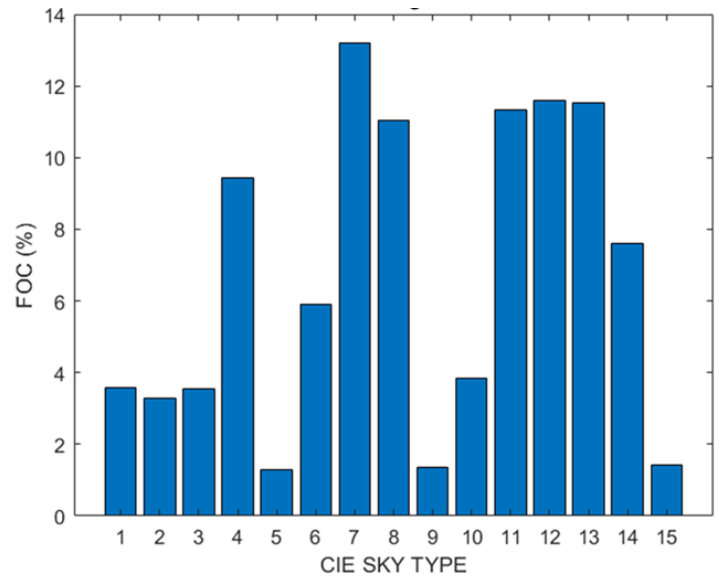
Figure 5. Frequency of occurrence (FOC, %) of CIE standard skies in Burgos, Spain, between September 2016 and January 2019.